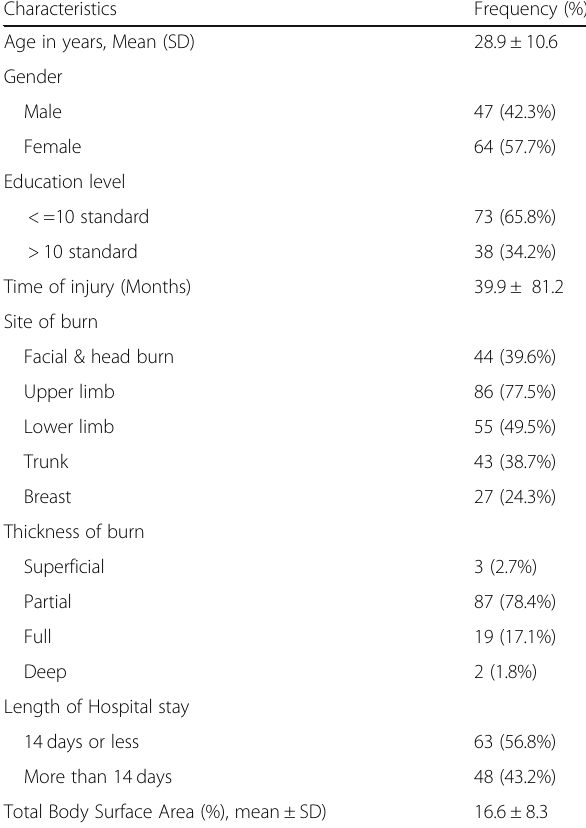
Table 1 Baseline demographics of the study participants. ( n